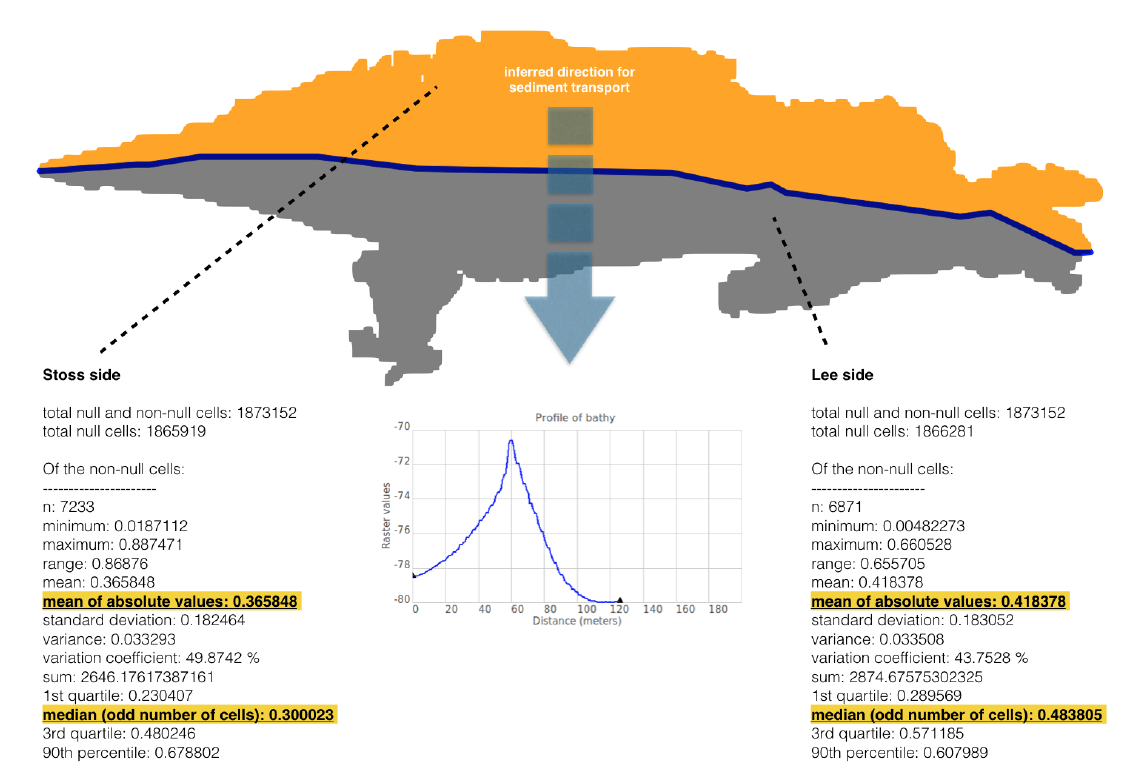
Figure 32. Bedform report, output of r.dune . The different colors indicate the stoss (yellow) and lee (gray) sides of the bedform. The tool runs a number of vertical profiles along transects perpendicular to the dune crest (blue). The spacing between transects is controlled by a parameter set (by default) to the DBM cell size in meters, same for the length of the transect which is (by default) set to be equal to the sand crest length (in meters). The vertical profile chosen for the report is the one with the greatest (or maximum) difference in